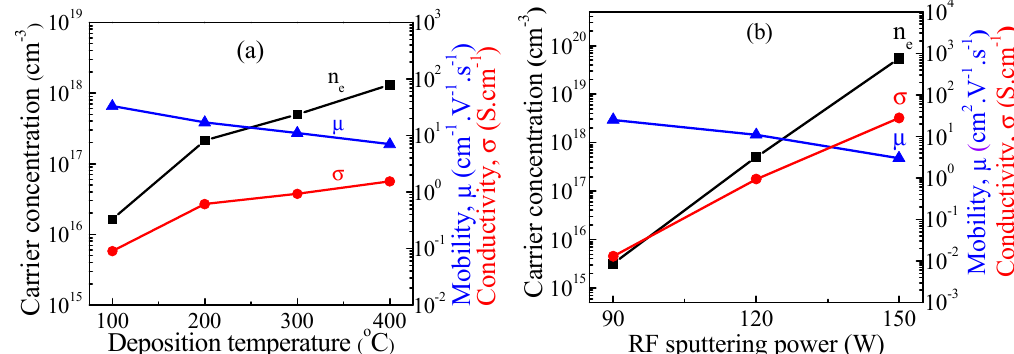
Figure 5. Electrical properties of Ge 0.07 GaN films deposited under a ( a ) heating substrate temperature range of 100–400 °C, ( b ) RF sputtering power from 90 to 150 W.